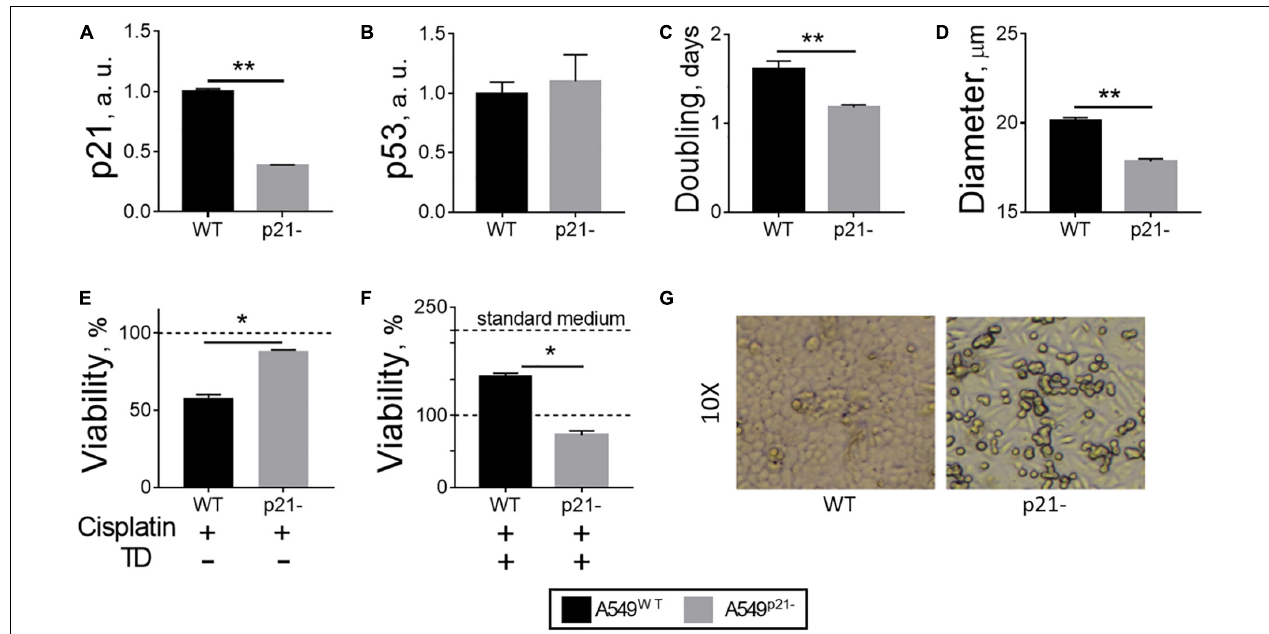
FIGURE 1 | Changes in A549 cells, observed upon p21 knockdown. (A) p21 mRNA transcripts. (B) p53 protein. (C) Doubling time during growth in culture in log phase. (D) Diameter of detached cells. (E) Cellular viability after 24 h incubation of the cells with 5 µ M cisplatin in standard medium. (F) Cellular viability after 24 h incubation of the cells with 5 µ M cisplatin in thiamine-deficient (TD) medium. (G) Morphology of A549 WT and A549 p21 − cells grown in standard medium for 6 days, shown at a 10-fold magnification. In (A,B) , a.u. define arbitrary units of expression. In (E,F) , the viability is assessed by cellular NAD(P)H:XTT reductase activity and normalized to control values without cisplatin in the standard (E) and thiamine-deficient (F) media. In view of a 2-fold decrease of the viability by thiamine deficiency, 100% NAD(P)H:XTT reductase activity in (E) corresponds to 218% of NAD(P)H:XTT reductase activity in (F) , shown by additional dash line “standard medium.” The data are averaged from the three independent experiments. Values are presented as mean ± SEM. Statistically significant differences are determined according to the Mann-Whitney test. Different p -values are shown by asterisks as described in Materials and Methods under Statistical Analysis section.